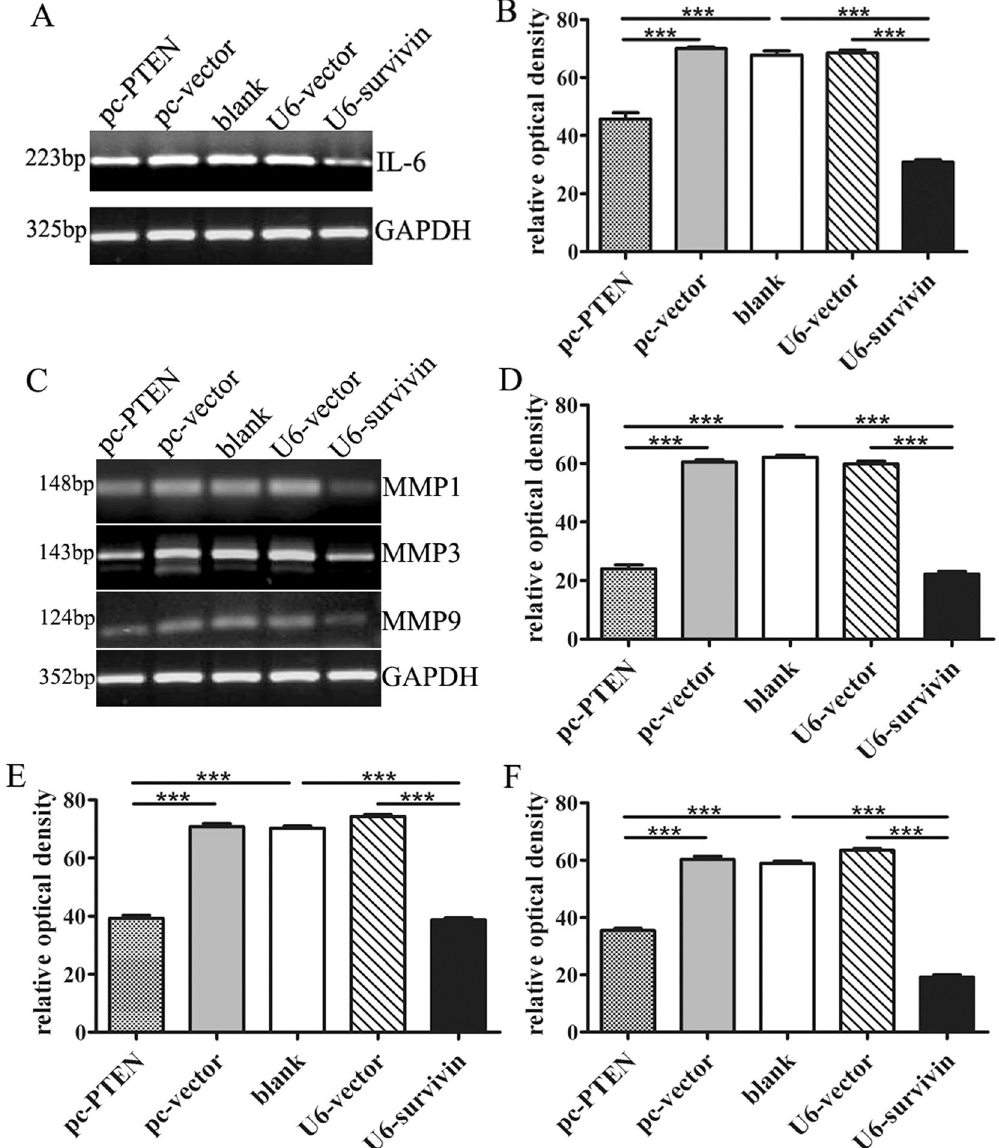
Figure 6. The inflammation cytokine IL-6 ( A ) and invasion molecules MMP1, MMP3 and MMP9 ( C ) were down-regulated by PTEN over-expression and survivin knock-down in the direct qPCR results with internal control of GAPDH. The change of relative optical density in three parallel experiments of IL-6 ( B ), MMP1 ( D ), MMP3 ( E ) and MMP9 ( F ) were analyzed to be significant (P <